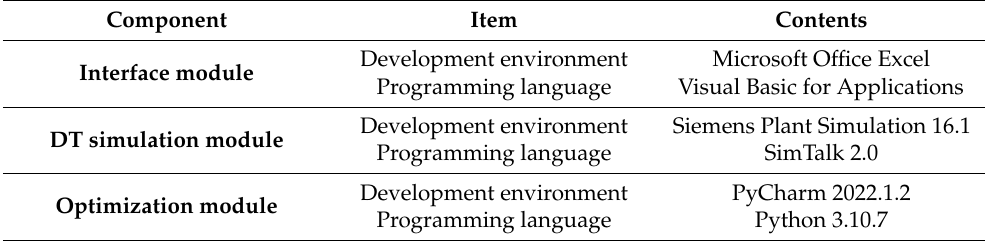
Table 2. Information on the development environment for DT application.